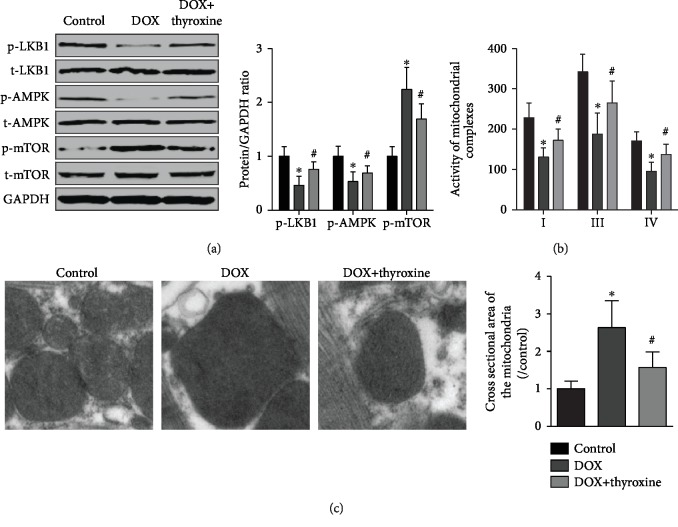
Effects of thyroxine on LKB1/AMPK/mTOR axis phosphorylation and mitochondrial complex I, III, and IV activation. (a) Representative images and quantification of p-LKB1, t-LKB1, p-AMPK, t-AMPK, p-mTOR, t-mTOR, and GAPDH in the LV for each group by western blot. (b) The activation of mitochondrial complexes I, III, and IV in the three groups was determined. (c) The cross-sectional area of the mitochondria in each group and more than 50 mitochondria were analyzed (5000x). N = 6 in each group. ∗P < 0.05 vs. control group; #P < 0.01 vs. DOX group.